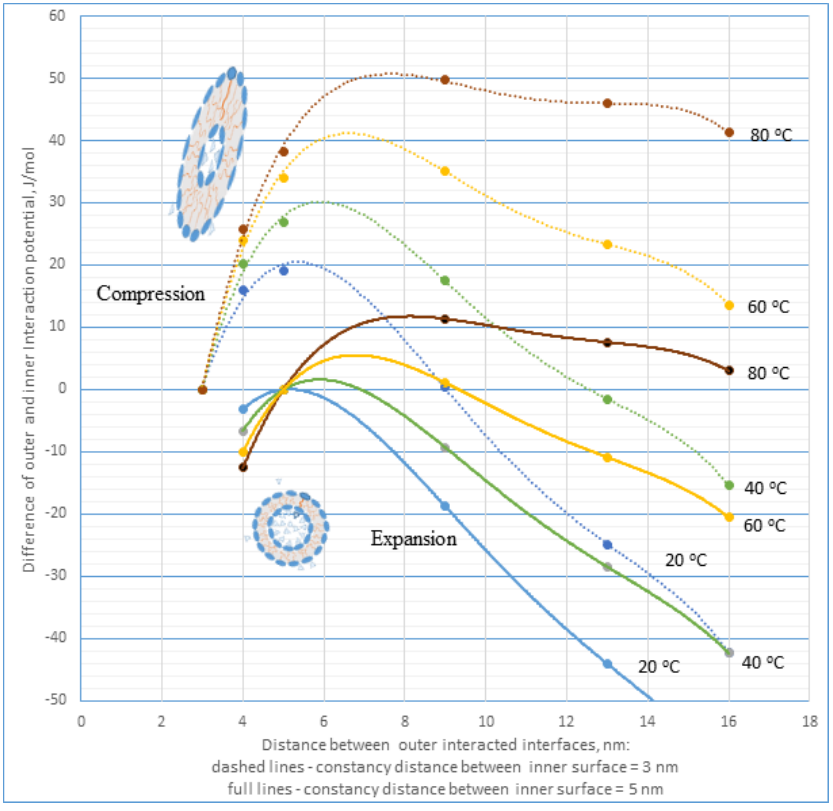
Figure 10. Theoretical dependences of difference between the outer and inner interaction potential characterizing the hydration forces influencing a deformation of closed (inner) hydromesophase in micro-objects with bilayers walls vs. distance of outer interacting interfaces relative to invariable distance of inner interface d o = 3 or 5 nm. The difference of interaction potentials models a mutual interaction of two micro-planes with mosaic type organization of the hydrated sites (see Appendix B). A temperature influence is evident as well.